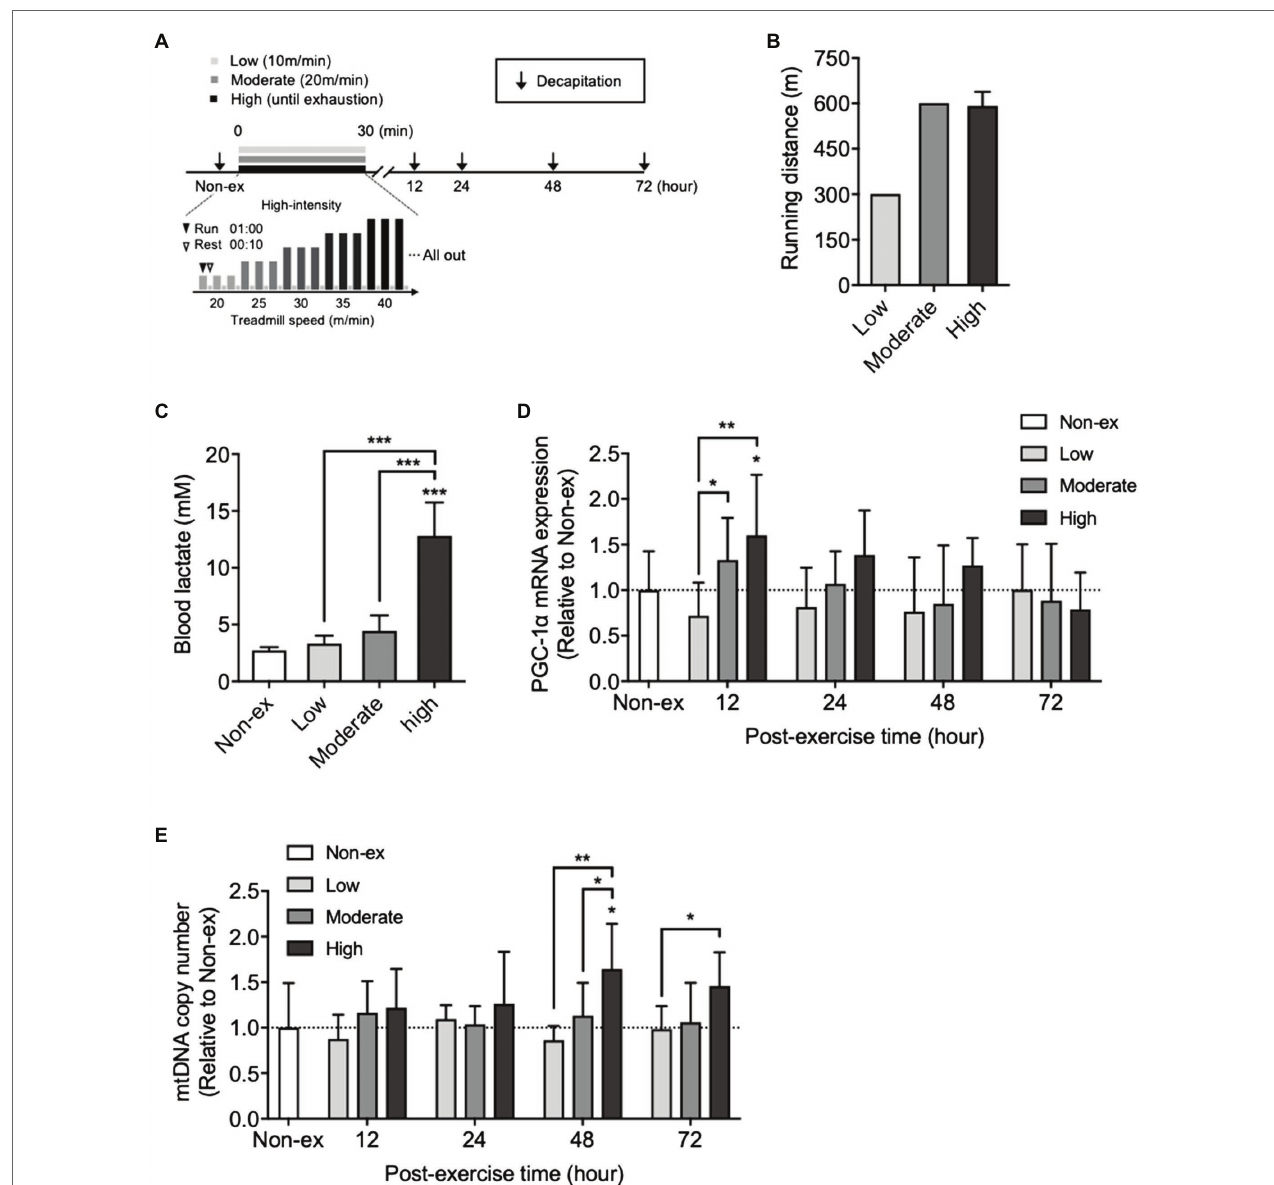
FIGURE 1 | Effects of a single bout of exercise performed at three different intensities on peroxisome proliferator-activated receptor gamma-coactivator 1 α (PGC-1 α ) mRNA expression and mitochondrial DNA (mtDNA) copy number in the hippocampus and on blood lactate levels. (A) Protocols for a single bout of exercise. The mice ran on a treadmill at three different intensities: low intensity (low): 10 m/min for 30 min; moderate intensity: 20 m/min for 30 min (moderate); and high intensity: the treadmill speed was initially set at 20 m/min and gradually increased by 5 m/min until the mice were exhausted. (B) Running distance for 30 min at low- and moderate-intensity exercise groups and exhaustion at high-intensity exercise group. (C) Blood lactate levels immediately after a single bout of exercise at three different exercise intensities. (D) Time course changes in PGC-1 α mRNA expression, and (E) mtDNA copy number in the hippocampus at non-exercise (Non- ex), 12, 24, 48, and 72 h after three different exercise intensities (Non-ex, n = 9; low, n = 8–10/group; moderate, 8–10/group; high, 8–10/group). All data were presented as the mean ± SD values. Data were analyzed using one-way ANOVA with Tukey’s post-hoc tests or two-way ANOVA with Bonferroni’s post-hoc tests. * p < 0.05; ** p < 0.01; and *** p < 0.001 in comparison with the non-exercise group if not otherwise